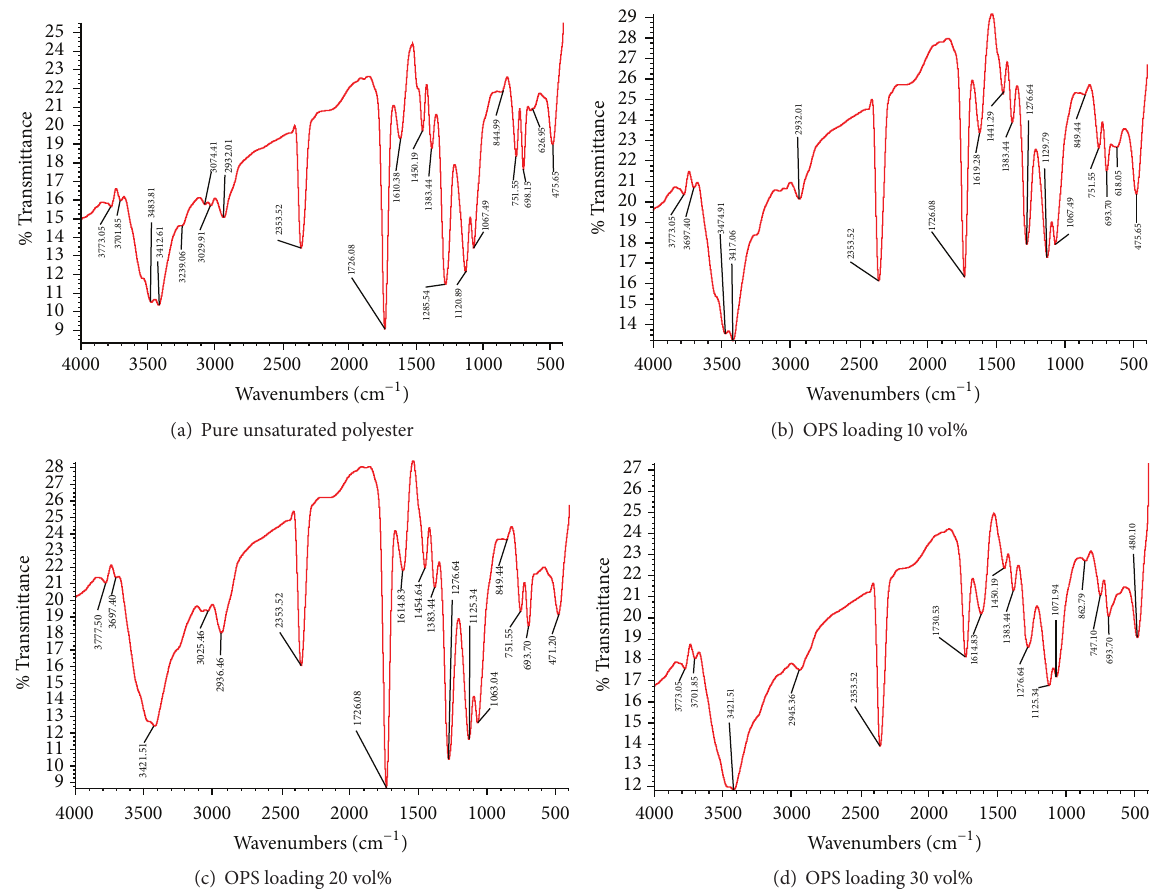
Figure 4: FTIR of UPE/OPS